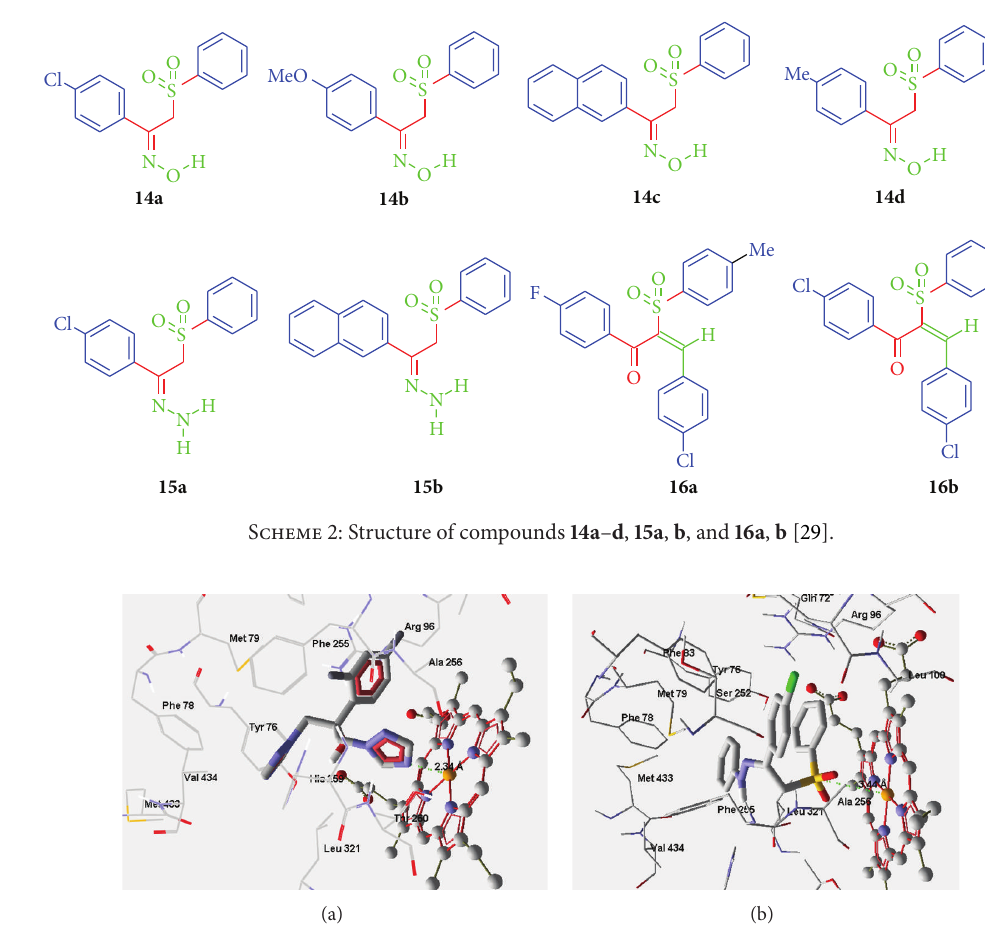
Figure 2: (a) Binding mode of fluconazole into the binding site cytochrome P450 14 𝛼 -sterol demethylase. (b) Binding mode of 13 into the binding site cytochrome P450 14 𝛼 -sterol